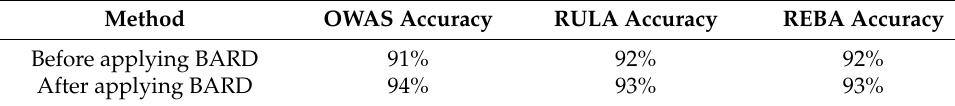
Table 3. Example of RULA score chart for input images.